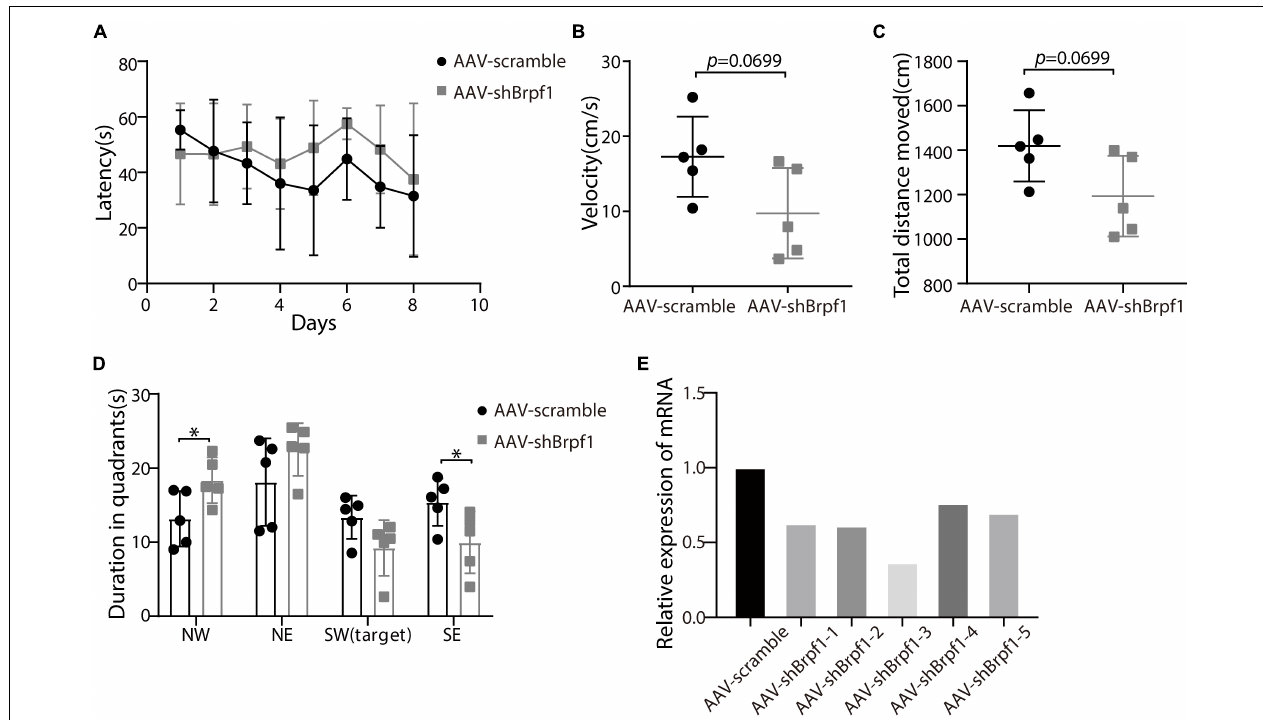
FIGURE 4 | Mild knockdown of Brpf1 showed a decreasing trend on the learning and memory ability of mice. (A) Statistical comparison of the latency of the mice to reach the platform during the 8-day training period (AAV-scramble, n = 5 mice; AAV-shBrpf1, n = 5 mice). (B) Statistical comparison of the average swimming speed of mice on day 8 in the target quadrant (AAV-scramble, n = 5 mice; AAV-shBrpf1, n = 5 mice; p = 0.0699). (C) Statistical comparison of the total moving distance of mice in the target quadrant (AAV-scramble, n = 5 mice; AAV-shBrpf1, n = 5 mice; p = 0.0699). (D) Statistical comparison of the time spent in different quadrants on day 8 (AAV-scramble, n = 5 mice; AAV-shBrpf1, n = 5 mice; ∗ p < 0.05). (E) Relative expression of Brpf1 mRNA in the hippocampus of each mouse compared to the scramble